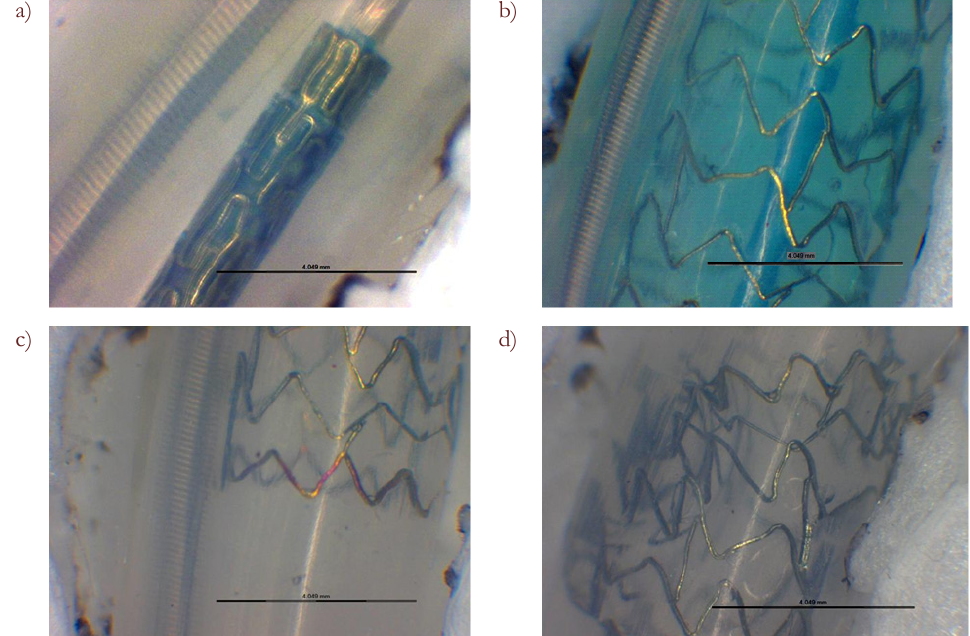
Figure 4: Stereomicroscopic pictures of the procedure: stent is crimpled and electrode is in the tube (a), balloon expanded stent (b), fixed electrode (c), stent after the extraction of the electrode (d).